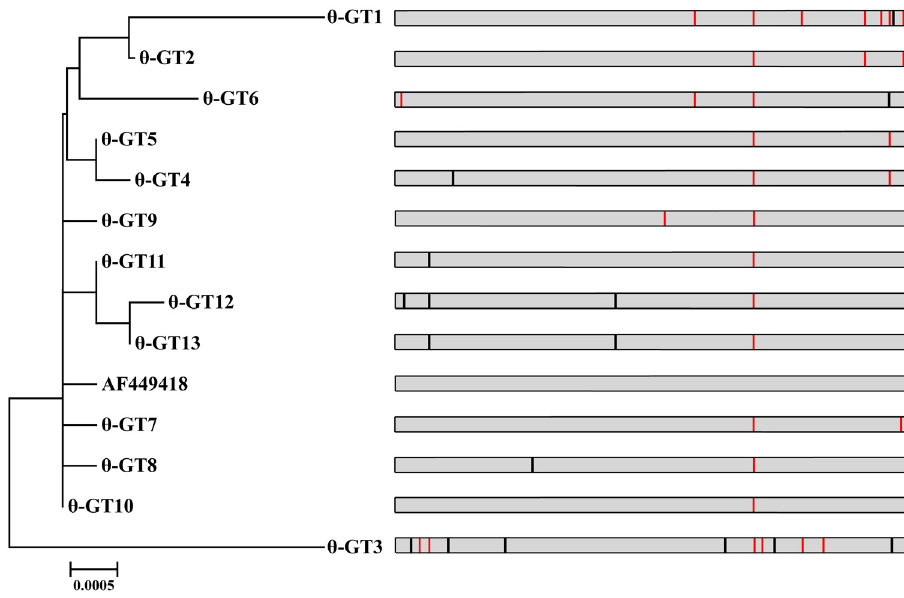
Fig 3. Neighbor-joining tree of 13 genotypes of eae genes among the 27 eae - θ strains and one reference sequence (AF449418). Polymorphic sites in the intimin alleles were illustrated. Black vertical lines indicate synonymous polymorphic sites and red vertical lines represent non-synonymous polymorphic sites. GT: genotype.